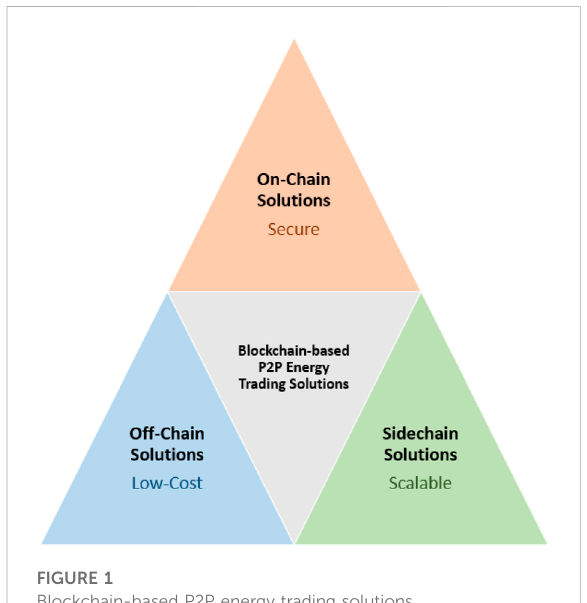
FIGURE 1 Blockchain-based P2P energy trading